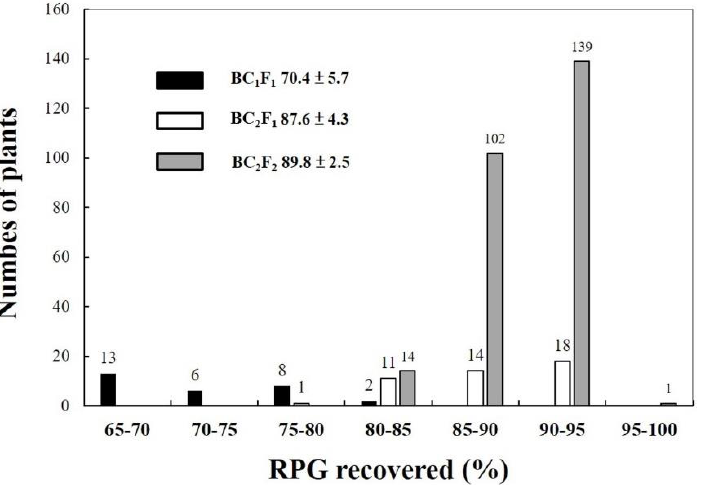
Figure 7. Frequency distribution of the recurrent parent genome (RPG) recovery rate estimated by markers in the BC 1 F 1 , BC 2 F 1 , and BC 2 F 2 generations of the red functional rice population. Based on the seed color of the BC 2 F 3 seeds, they were classified into five groups as TNGSW26; 4 individuals in the light red group; 15 in the dark group, 16 in the white group; and 3 in the mixed color group (white and red mixture). Most of the BC 2 F 3 seeds, regardless of the color, had larger embryos than the recurrent parent TNGSW26 (Figure 8), and the giant embryo was the desired trait derived from the donor parent CNY103107. Only 13 individuals (RFR1, 2, 13, 16, 21, 22, 34, 36, 39, 44, 46, 48, and 51) from the red color group were retained for the five-season yield trial (Table 1). The trials were combined with the PFR population and checks (TNGSW26 and CNY922401). The DPPH scavenging activity was also calculated for these 13 lines (Table 2), and the results were considered as important selection guidelines. Figure 8. Grain appearance of brown rice for ( A ) TNGSW26 and ( B – D ) BC 2 F 3 individuals, which had larger embryos than TNGSW26.